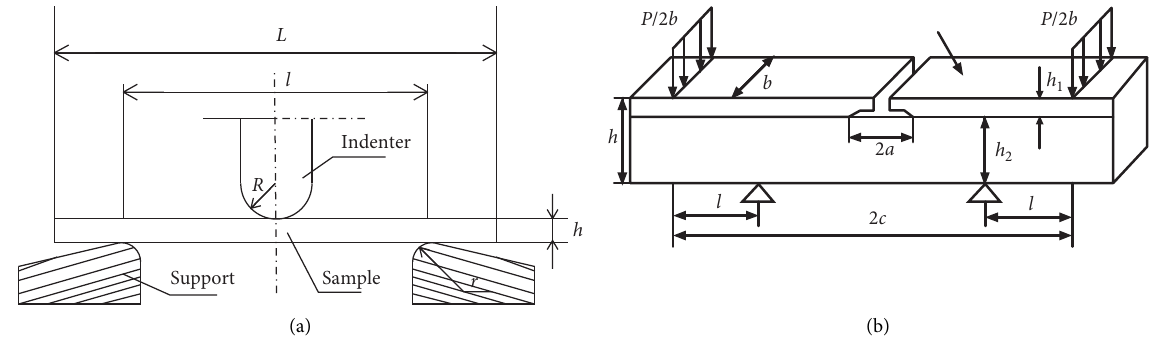
Figure 8: Common types of SBS [38]. (a) Three-point bending method. (b) Four-point bending method. Clamp Stiffener Magnesium Composite arm